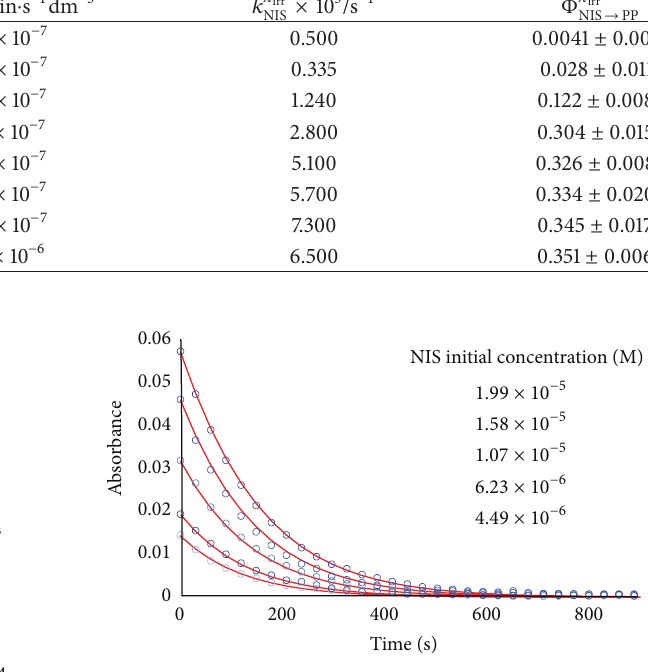
Figure 4: Photokinetic traces of NIS ethanolic solutions of various concentrations (4.49 × 10 −6 –1.99 × 10 −5 ) when irradiated at 350 nm and observed at 390